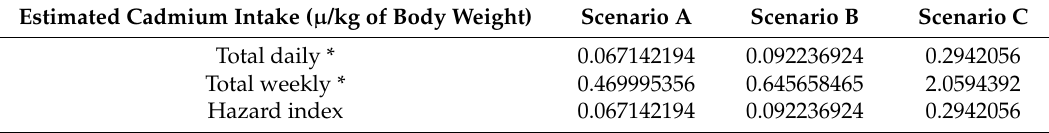
Table 9. Baroševac adult population’s weekly cadmium intake and hazard index (semi-probabilistic